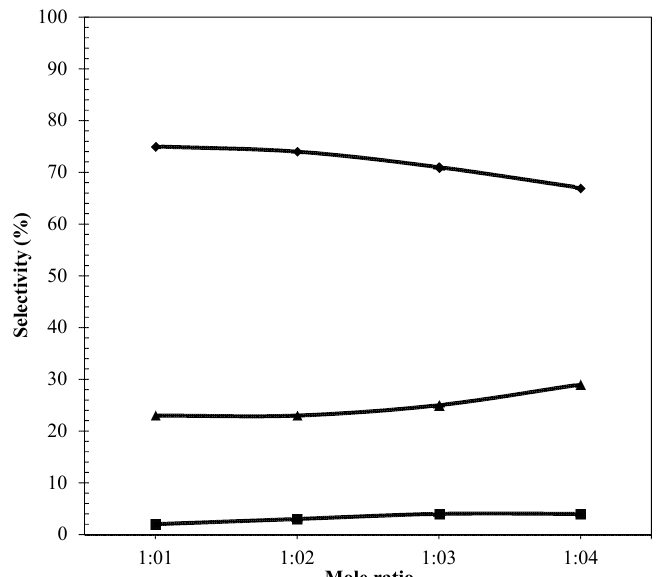
Figure 8. Effect of mole ratio on selectivity. Speed of agitation 1000 rpm, temperature 150 °C, catalyst loading 0.03 g/cm 3 reaction duration 4 h. (